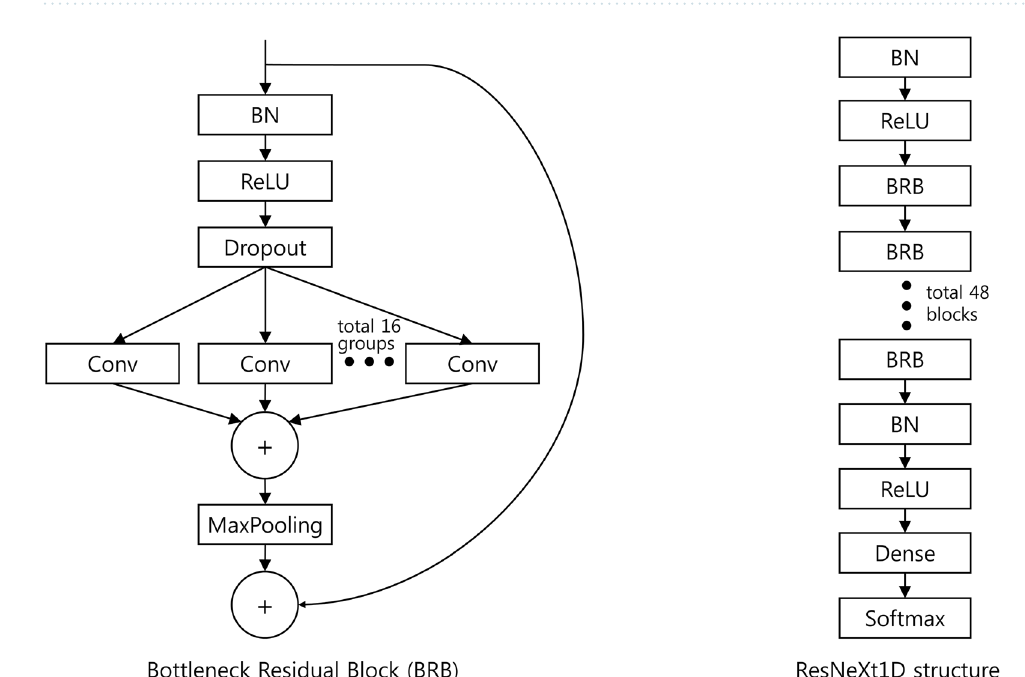
Figure 3. A bottleneck residual block (left) and our customized structure (right) of